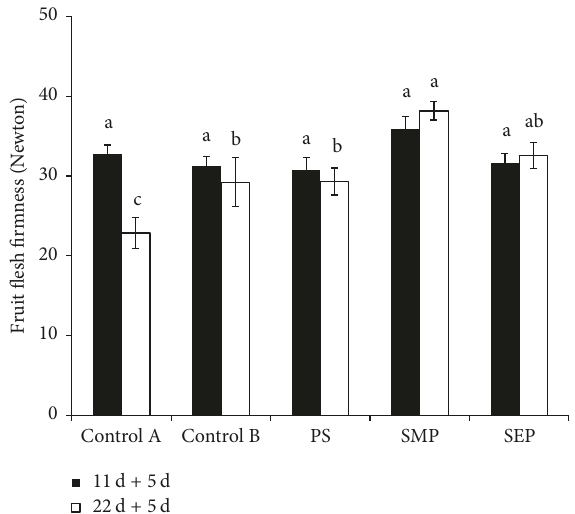
Figure 2: Fruit flesh firmness of “Friar” plums uncoated or coated with hydroxypropyl methylcellulose-beeswax edible coatings con- taining potassium sorbate (PS), sodium methyl paraben (SMP), or sodiumethylparaben(SEP)andstoredfor11and22dat1 ∘ Cfollowed by 5d at 20 ∘ C. Firmness at harvest was 47.08 ± 1.61 N. Control A: uncoated; Control B: coating without antifungal agent. For each storage time, bars with different letters are significantly different according to Duncan’s range test ( 𝑃 < 0.05 ) ( 𝑛 = 20